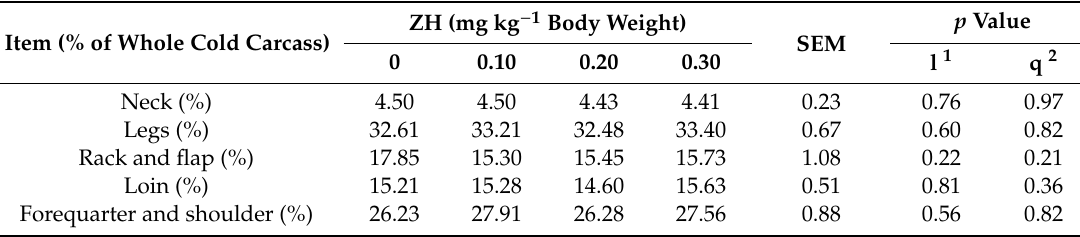
Table 4. Commercial cuts from lambs according to Australian meat standards of hair-breed lambs supplemented with di ff erent levels of ZH for 29 d.